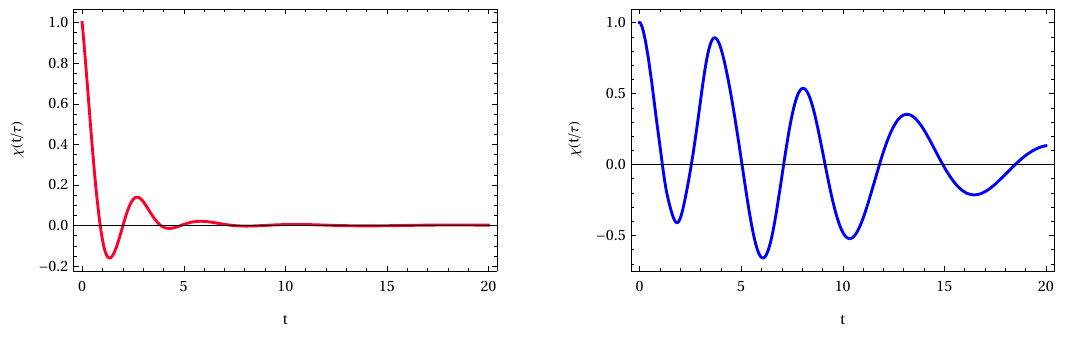
(cid:14) cosh ( t ) 2 and β ( t ) = cosh ( t ) with N = 128. Right